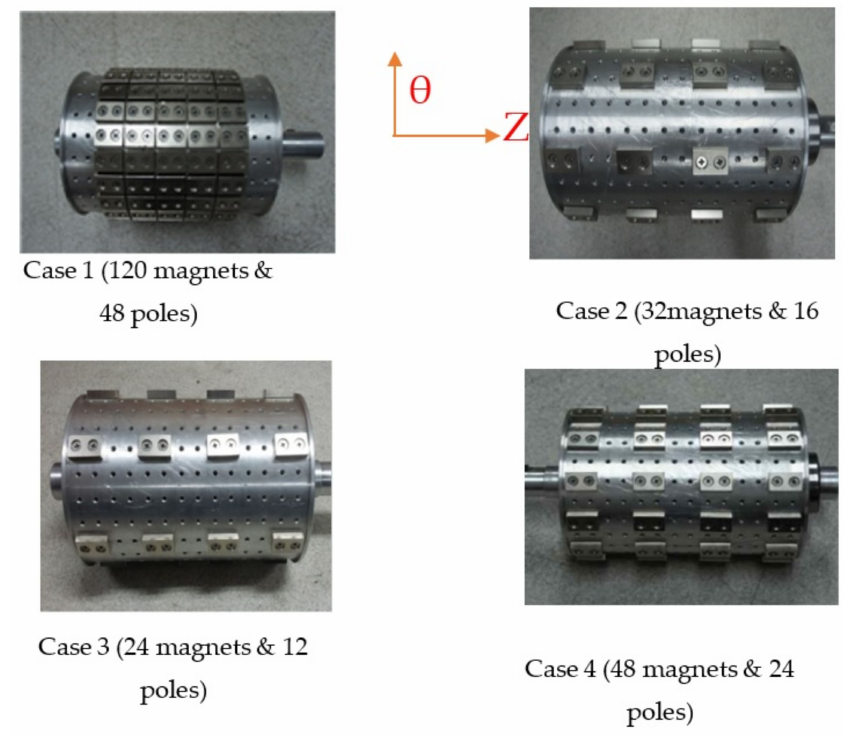
Figure 5. Four different rotors with different magnet